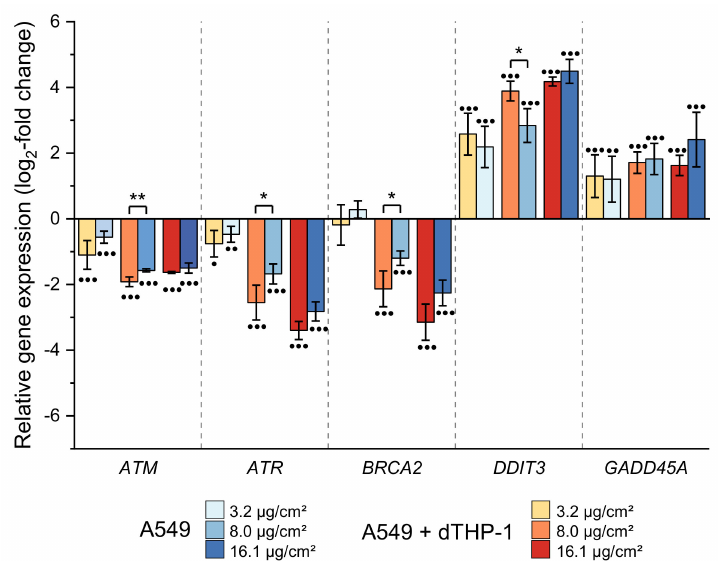
Figure 7. Impact of CuO NP on genes related to DNA damage response and repair in A549 monocul- ture (A549) and co-culture (A549+dTHP-1) after 24 h incubation. Depicted is the log 2 -fold change of at least three independently conducted experiments ± SD. Significantly different from negative controls: • ≤ 0.05, •• ≤ 0.01, ••• ≤ 0.001 (ANOVA-Dunnett’s t -test); significantly different between cell models: * ≤ 0.05, ** ≤ 0.01, *** ≤ 0.001 (unpaired t